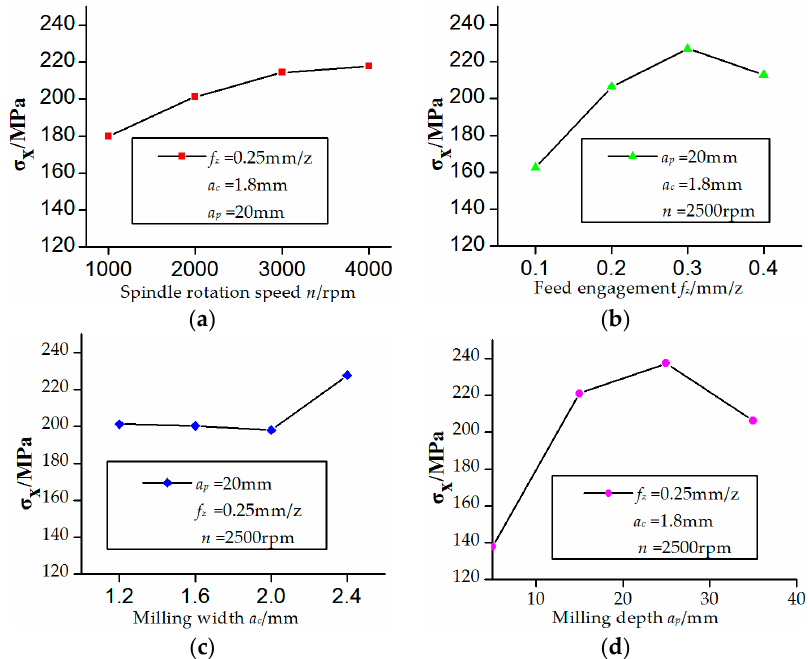
Figure 3. Effects of control factors on X -direction residual stress. ( a ) Relationship between spindle rotation speed and residual stress; ( b ) Relationship between feed engagement and residual stress; ( c ) Relationship between milling width and residual stress; ( d ) Relationship between milling depth and residual stress.